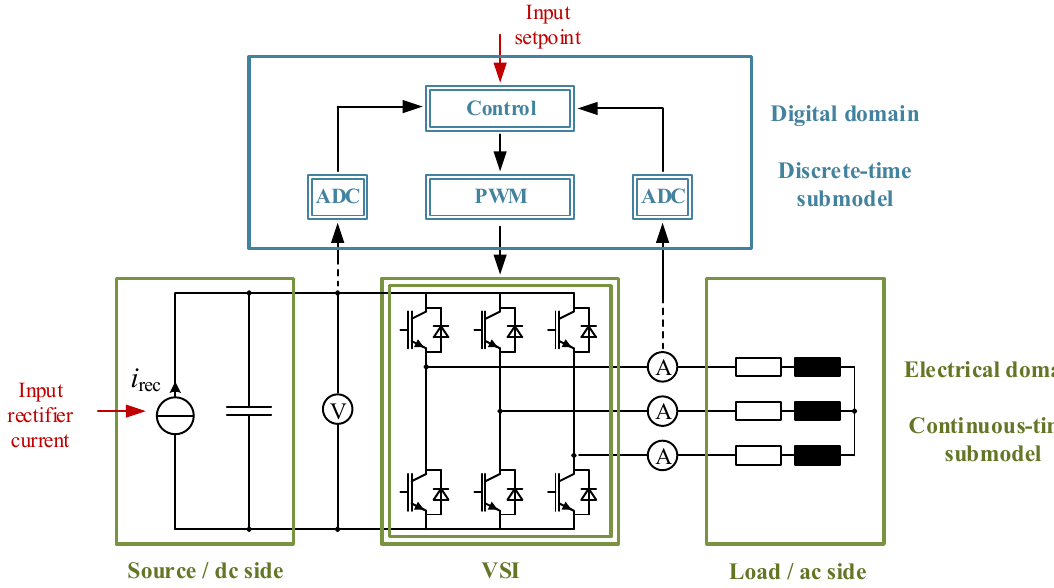
Figure 1. Topology of the example system. The two-level VSI connects a dc source to a three-phase passive load. The dc-link voltage and the ac-side currents are fed back via Analog-to-digital converters (ADCs) to the digital control, which regulates the switching state of the VSI via a pulse-width modulation (PWM). The power converter forms a closed-loop system, which is nonlinear due to the double framed blocks. The digital control in blue contains discrete-time signals and the electrical system in green is described by continuous-time signals. The system model has the rectifier current and the control setpoint as input signals displayed in